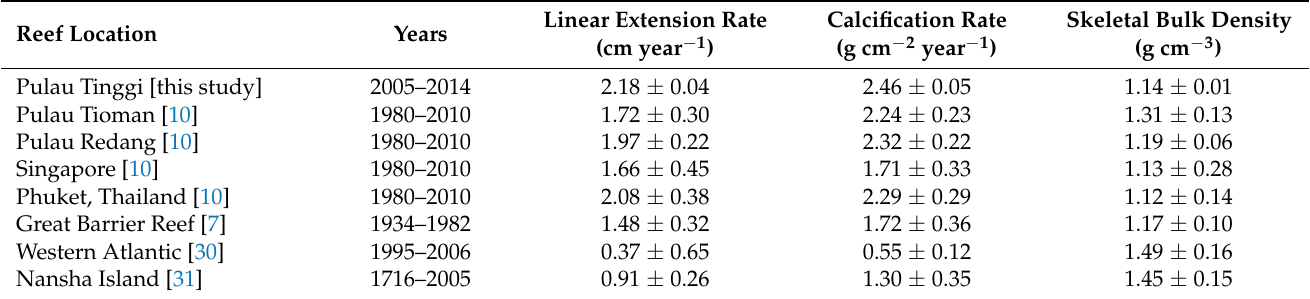
Table 1. Coral skeletal growth rates (mean ± S.E.) from different reef location in Southeast Asia and other region.